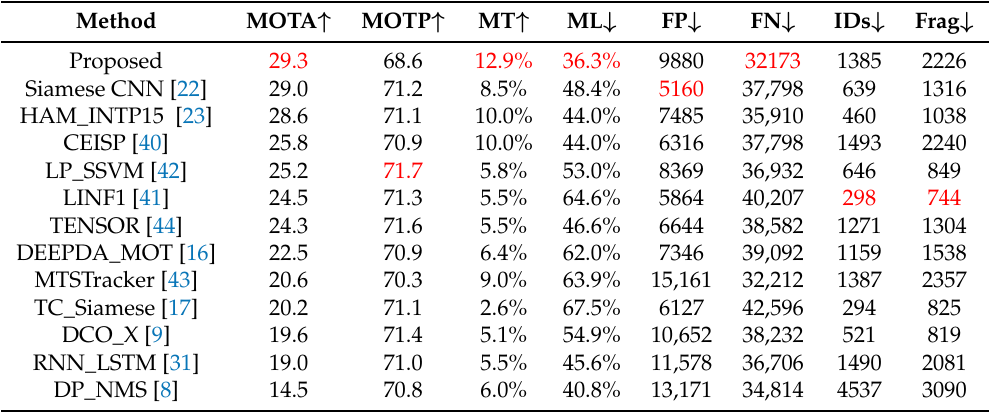
Table 4. Performance comparison of multiple object tracking (MOT) systems. Red represents the best. The upward arrow indicates the higher the better, and the downward arrow means the lower the better. MOTA, multiple object tracking accuracy; MOTP, multiple object precision; MT, mostly tracked; ML, mostly lost; Frag, the total number of times a trajectory is